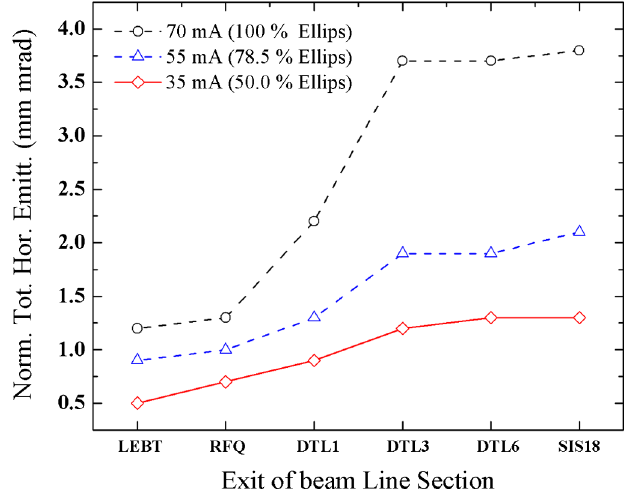
FIG. 34. The development of the emittance growth when 70 mA are injected from the RFQ. The three lines represent the growth of the emittances including 50%, 78%, and 100% of the beam intensity.